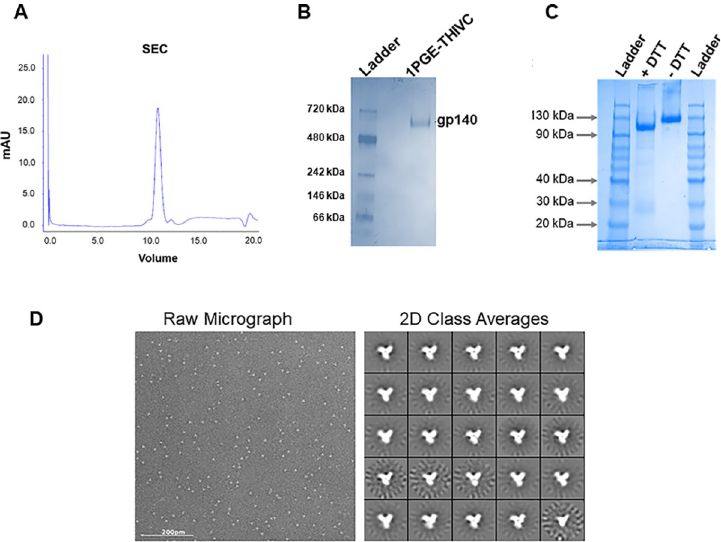
Fig 1. Purification of 1PGE-THIVC SOSIP. A. 1PGE-THIVC SOSIP was first purified by PGT145 antibody affinity column followed by size exclusion chromatography (SEC). B. The purified SOSIP trimer was examined by blue native gel electrophoresis. C. Efficient cleavage of 1PGE-THIVC trimeric Env was examined by running in SDS-PAGE under reducing conditions. D. The physical conformation of the SEC purified SOSIP trimers were examined by two- dimensional negative-stain EM class averages ( D)